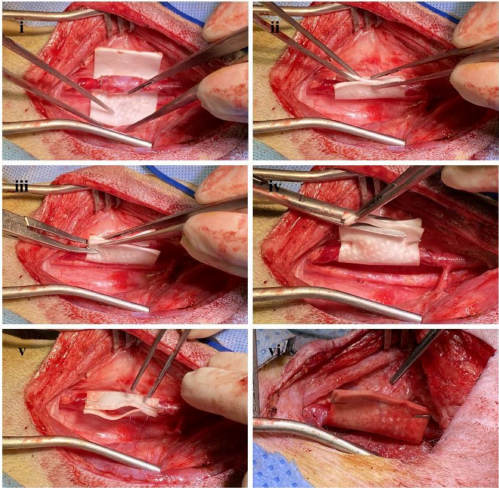
Figure 11. Detailed surgical procedures in the intervention group; (i) positioning of silk MN wrap to vein graft, (ii) wrapping the silk MN wrap around the vein graft, (iii) fixation of silk MN wrap with surgical clip, (iv) trimming of redundant wrap, (v) fixation of central portion with suture, (vi) completion of applying silk MN wrap to vein